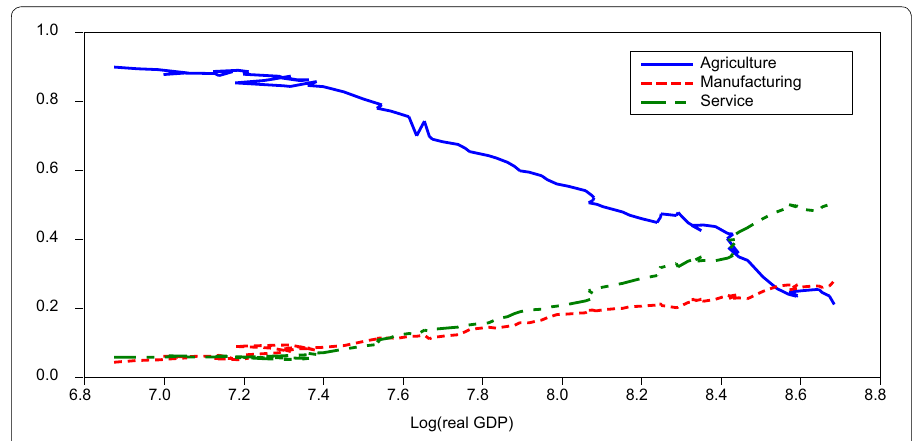
Fig. 2 Sectoral shares of workers in the three sectors, and GDP (annually, 1923–2014). Note : Real GDP is used for sectoral comparison, because it has a greater time span and it is favorable to do time series analysis with worker distribution. The manufacturing sector is the activities not categorized within the agricultural and ser- vice sector. GDP is expressed as US dollar. Source : Author’s calculation. Employment data were derived from TurkStat (employed persons by kind of economic activity). GDP is derived from Ministry of Development’s report (Economic and Social Indicators between 1950 and 2014) and calculated with exchange rate of 1998 to find real GDP in US dollars (1998 100) = Table 3 Correlation between sectoral shares of workers and GDP (annually,